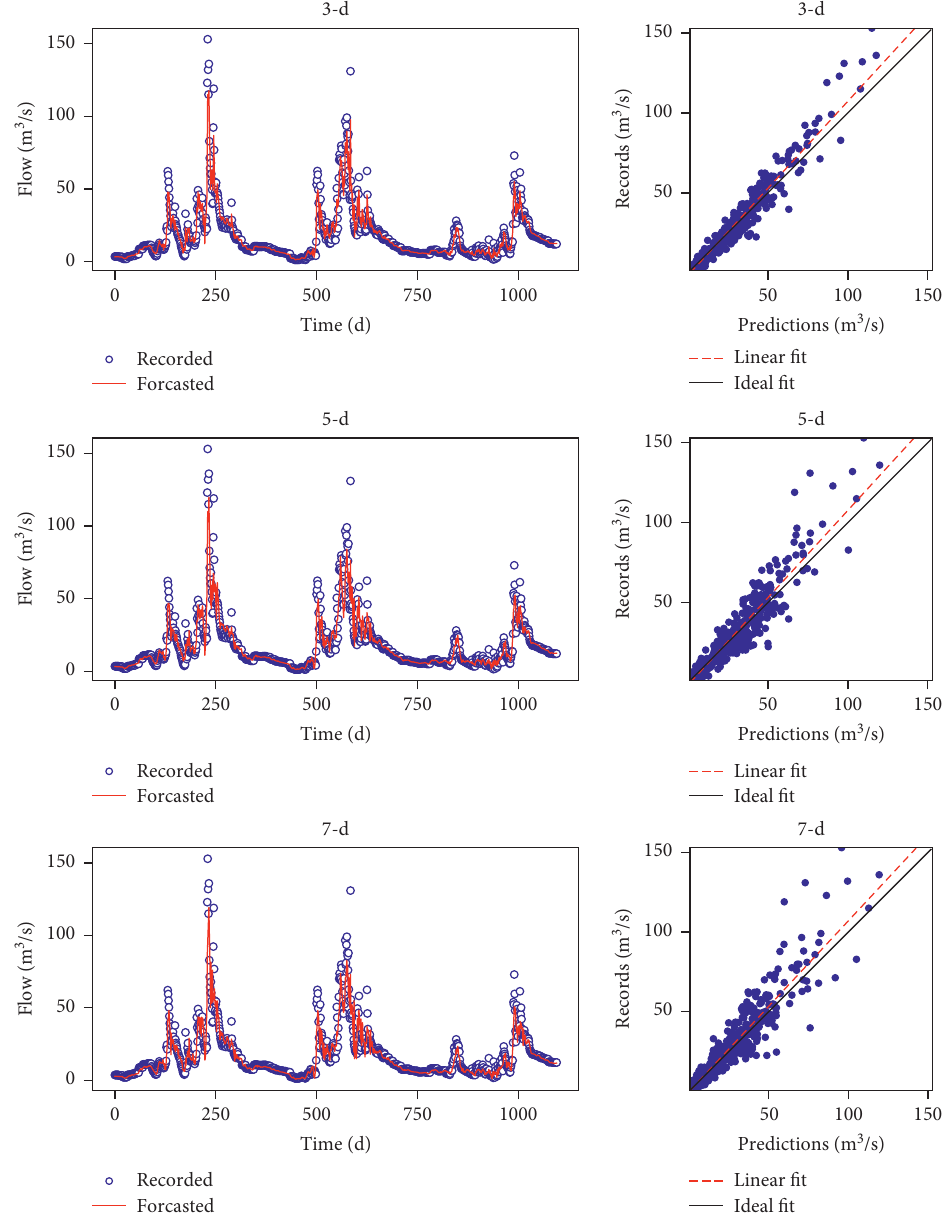
Figure 10: Final predicted results and the scatters of the VMD-BPNN for the 3-d, 5-d, and 7-d ahead forecasts at the Wushan